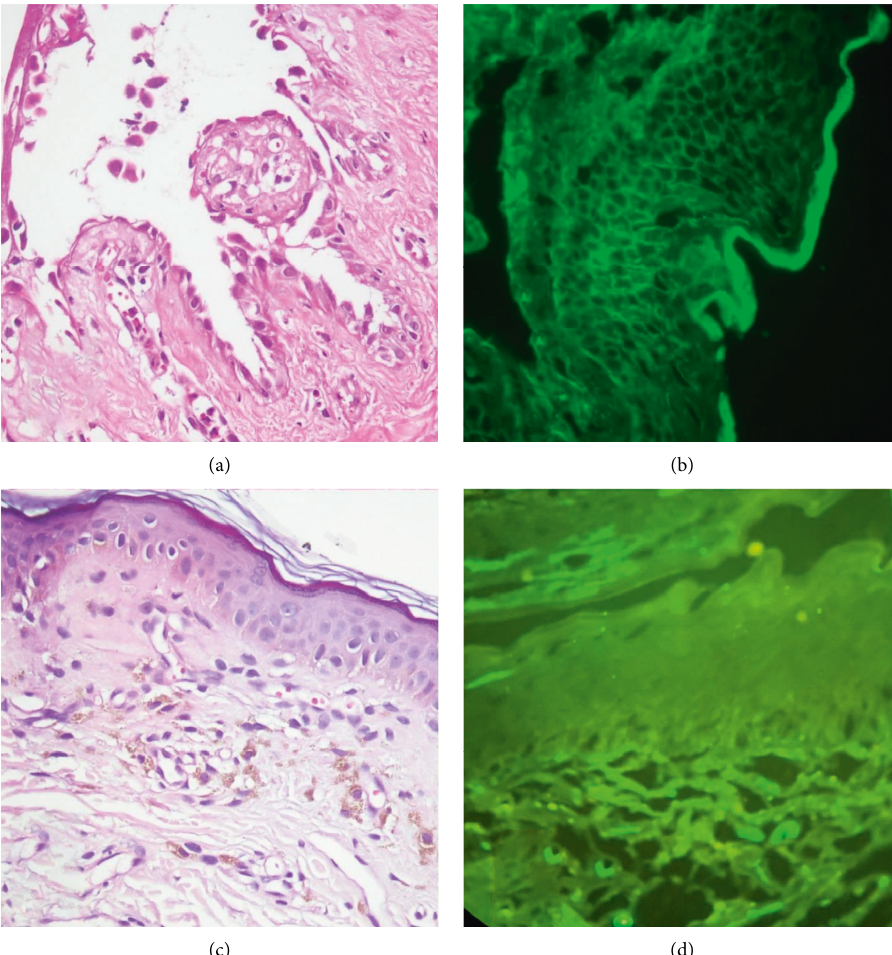
Figure 2: Suprabasal epidermal acantholysis and cleft containing inflammatory cells and rounded acantholytic cells with intensely eo- sinophilic cytoplasm and a perinuclear halo. DIF shows intercellular deposition throughout the epidermis compatible with diagnosis of PV (a, b). Hyperkeratosis, atrophic epidermis with vacuolar alteration of the basal cell layer, and pigmentary incontinence and negative. DIF, compatible with diagnosis of LP pigmentosus (c, d)